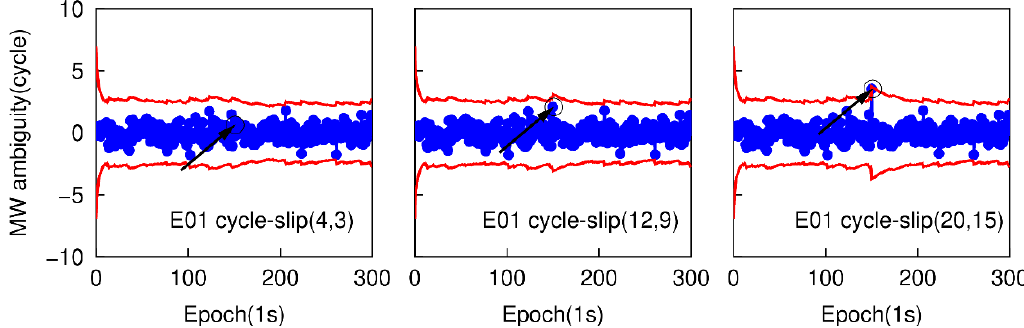
Figure 10. Specific small cycle-slip combination detection results with MW combination E01.